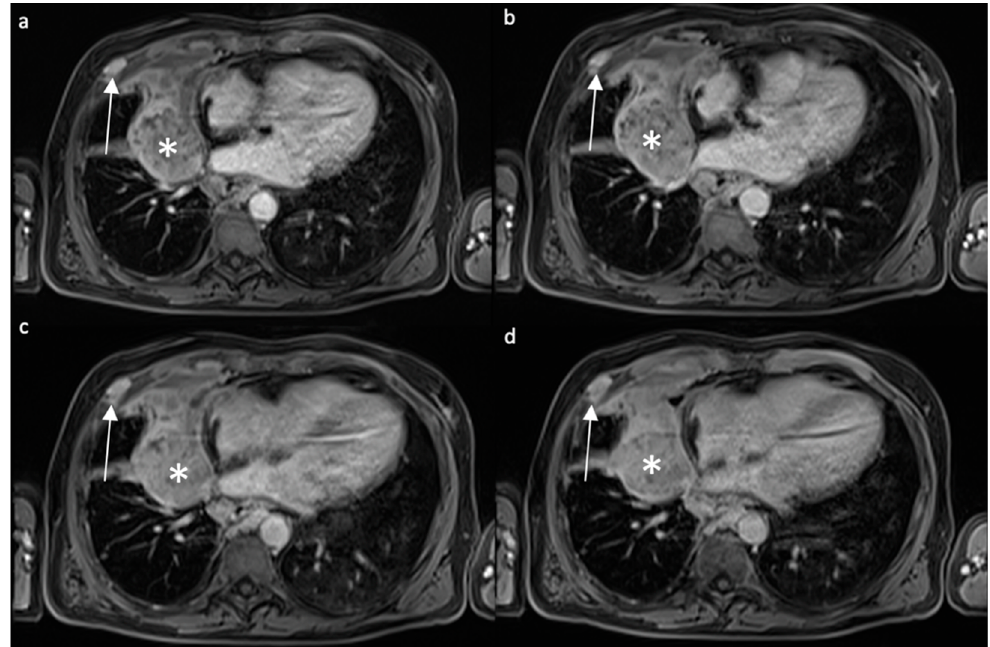
Figure 3. Contrast-enhanced T1w axial fat-saturated images acquired with different timing after contrast administration (( a ) 40 s, ( b ) 80 s, ( c ) 3 ′ , ( d ) 5 ′ ) in a patient affected by MPM. White asterisk: paramediastinal mass with peripheral enhancement, in particular in the anterior portion; white arrow: enhancing nodule in the anterior thoracic wall is present.